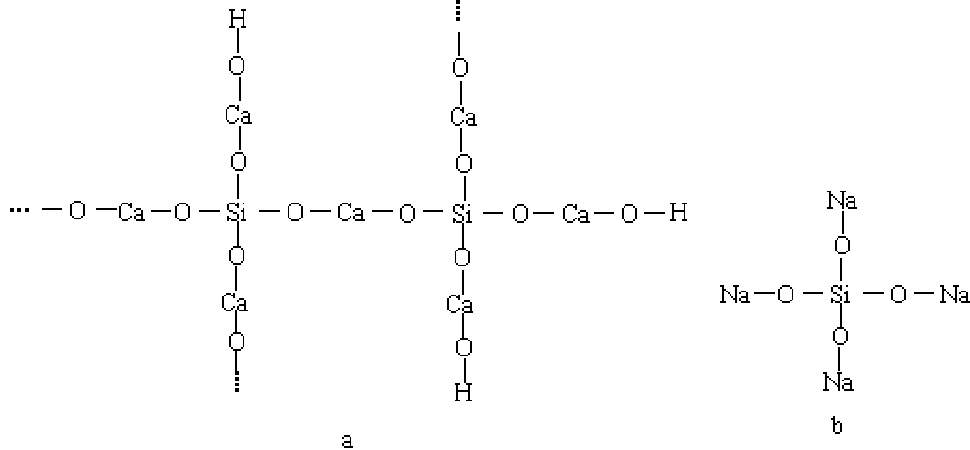
2 CO 3 or NaHCO 3 .